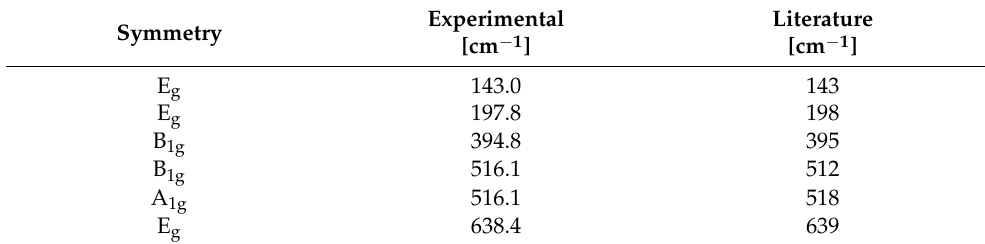
Table 1. Experimental and literature [28] TiO 2 anatase Raman-active modes, excited at 514.5 nm. Experimental Symmetry